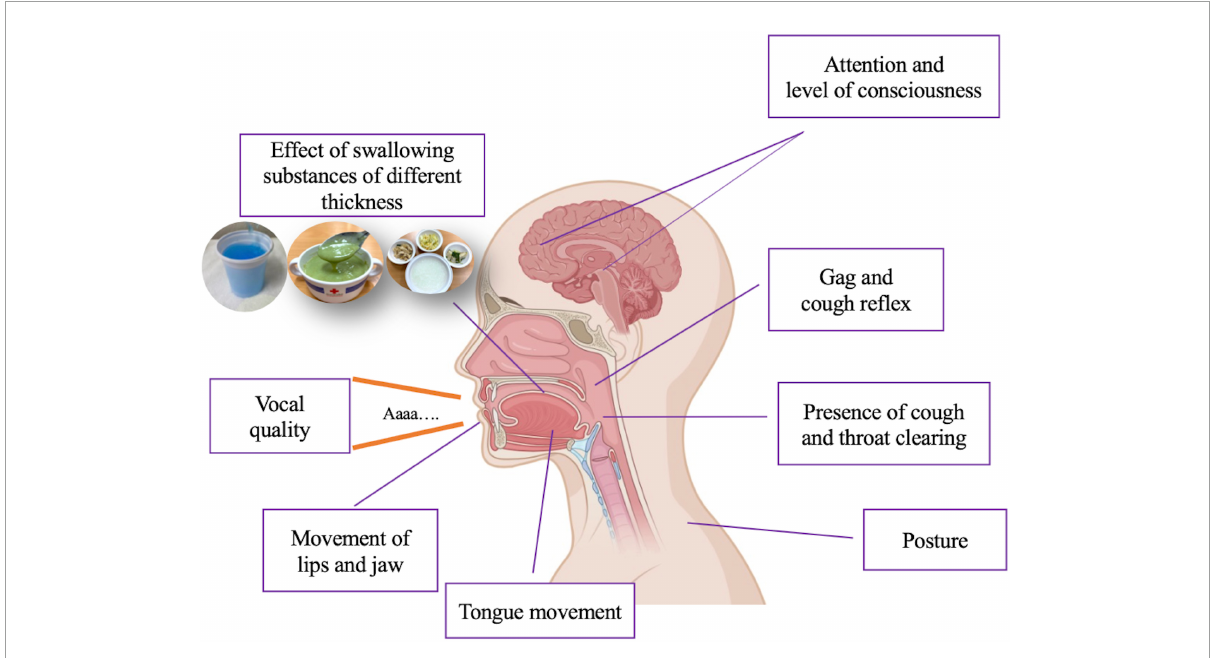
FIGURE2 Assessment of dysphagia in clinical practice. Created with BioRender.com.